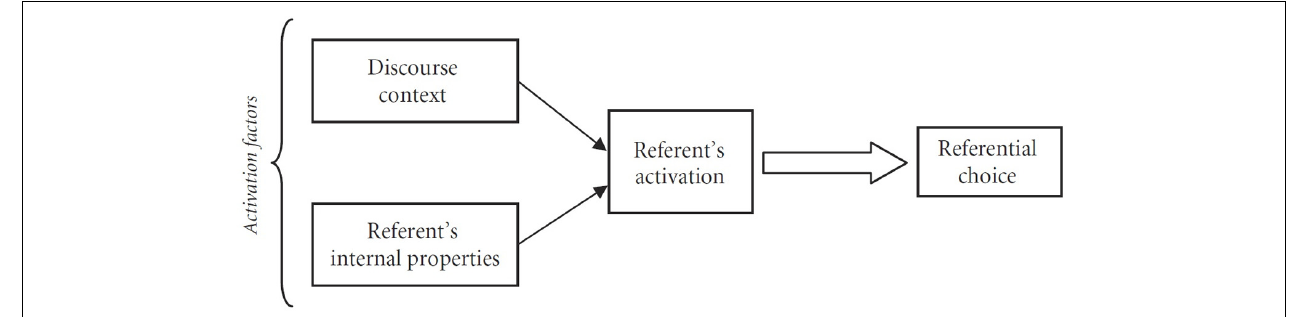
FIGURE 1 | Cognitive model of referential choice (cf. Kibrik, 2011, p.